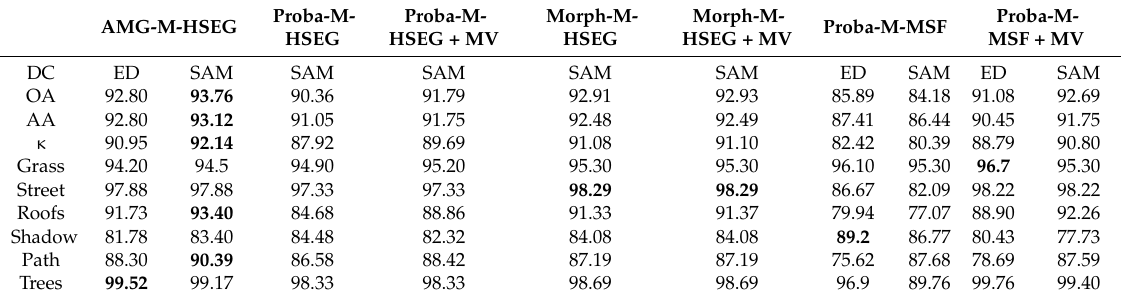
Figure 8. Sensitivity analysis of the GAs achieved by the AMG-M-HSEG method using the Washington DC image for l from 0 to 12. Table 3. The GAs and CAs (percent) for the Washington DC image using all the spectral-spatial classification methods for comparison. The highest accuracies are indicated in bold in each category.